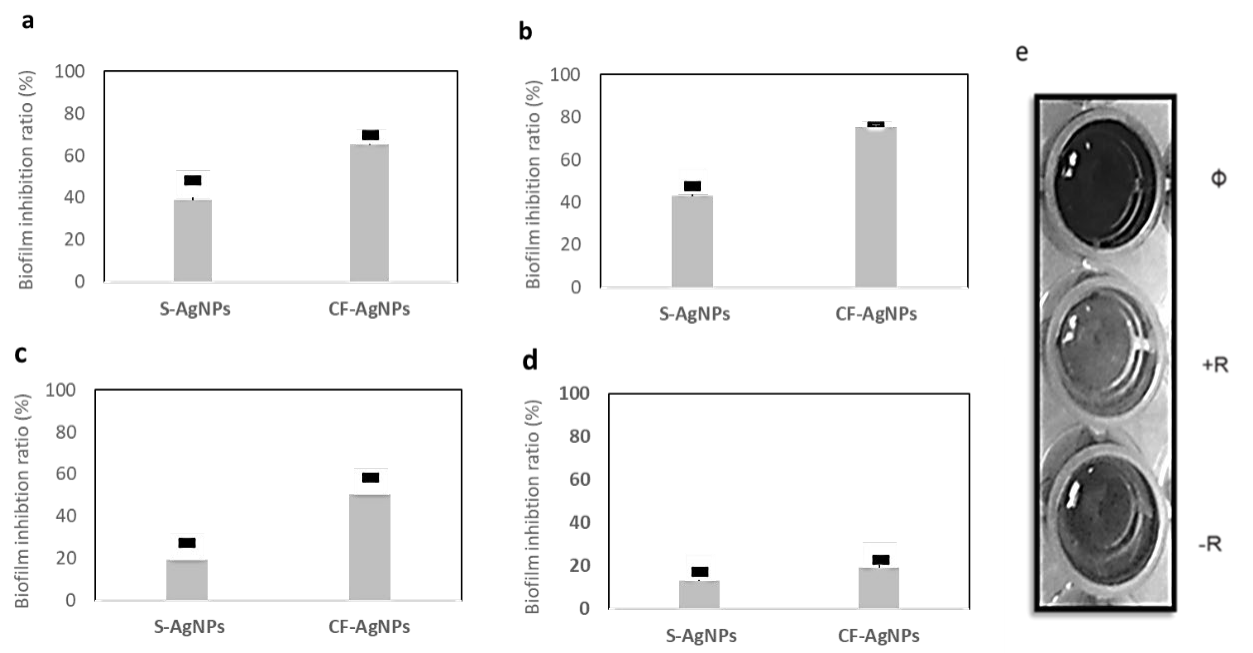
Figure 6. The biofilm inhibition ratio of AgNPs prepared by Streptomyces sp. ASM23 cell supernatant (S) and cell filtrate (CF) against four clinical microbes ( a ) B. subtilis , ( b ) E. coli ( c ) S. aureus , and ( d ) P. aeruginosa. The bars on the graph represent the mean of triplicate , and SD. ( e ) Microtiter plate, (Ø) blank, (+R) positive result, and ( − R) negative result.